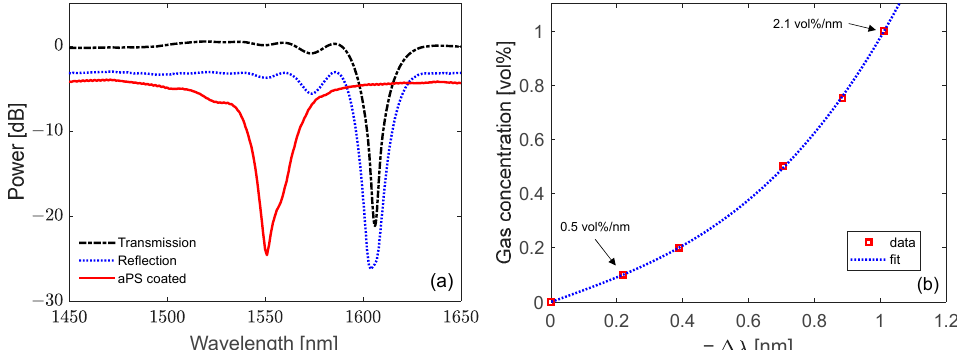
Figure 18. LPG-based gas sensor: ( a ) spectra acquired during fabrication steps (inscription, reflection configuration and with aPS coating); ( b ) response to different butane mixtures below the LEL, in terms of resonance wavelength shift. (Adapted from